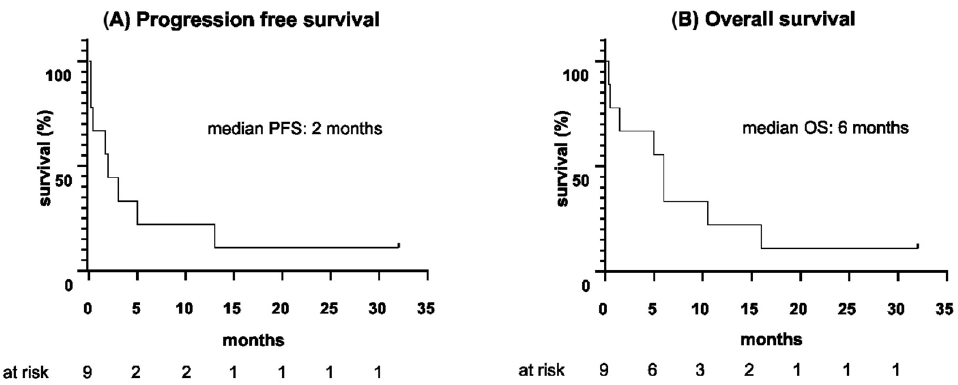
Table 6. Outcome of blinatumomab therapy. Data on medians.